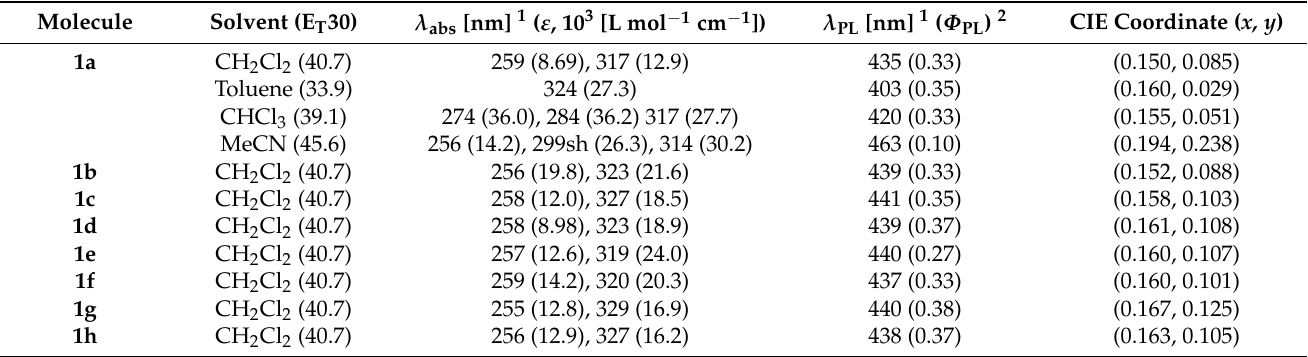
Table 2. Photophysical data of 1a – h in solution state.